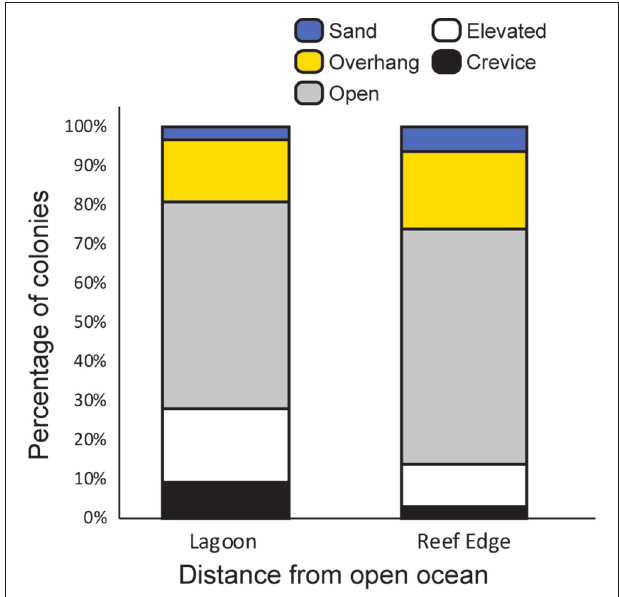
FIGURE 3 | Relative frequency of different microhabitats for Acropora colonies ( N = 596) observed at lagoonal sites ( > 510m from reef edge, 6 sites) and reef edge sites ( < 410m from reef crest, 4